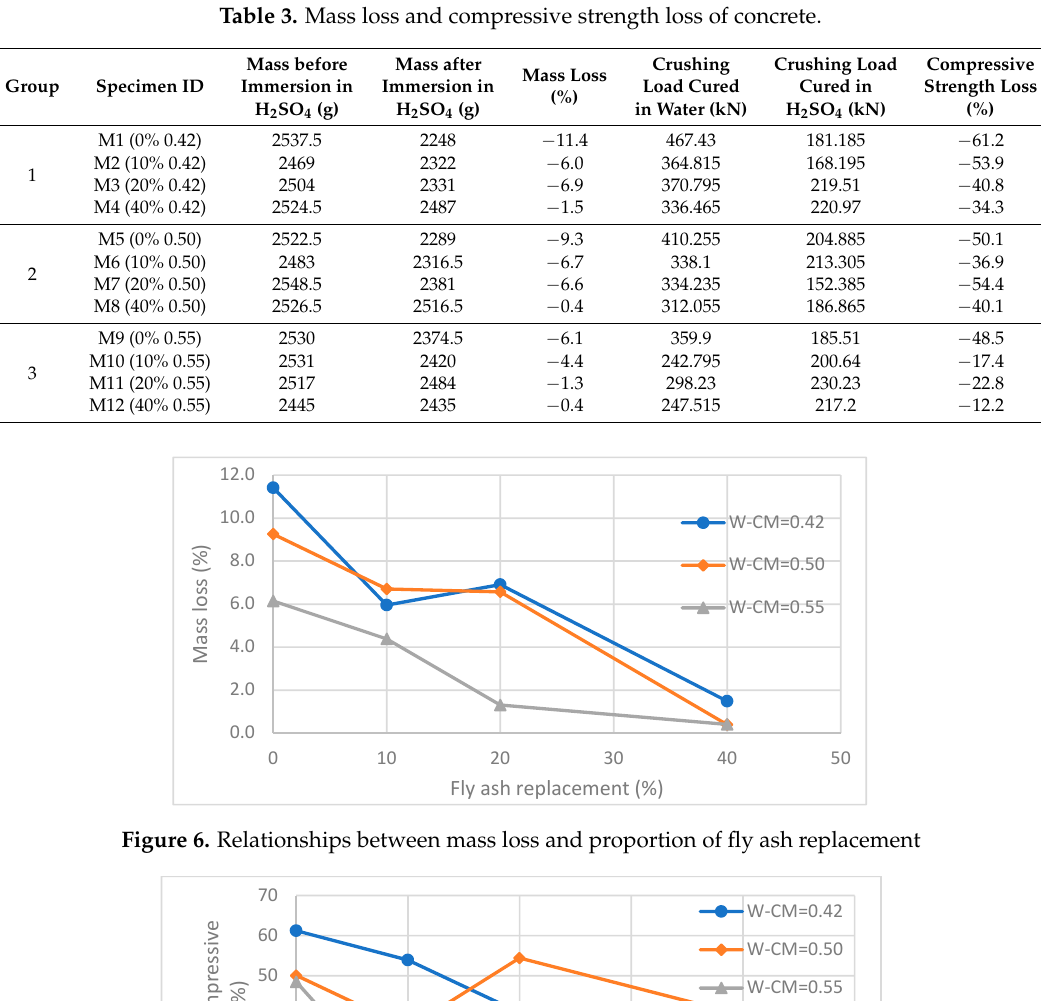
Table 3. Mass loss and compressive strength loss of concrete.